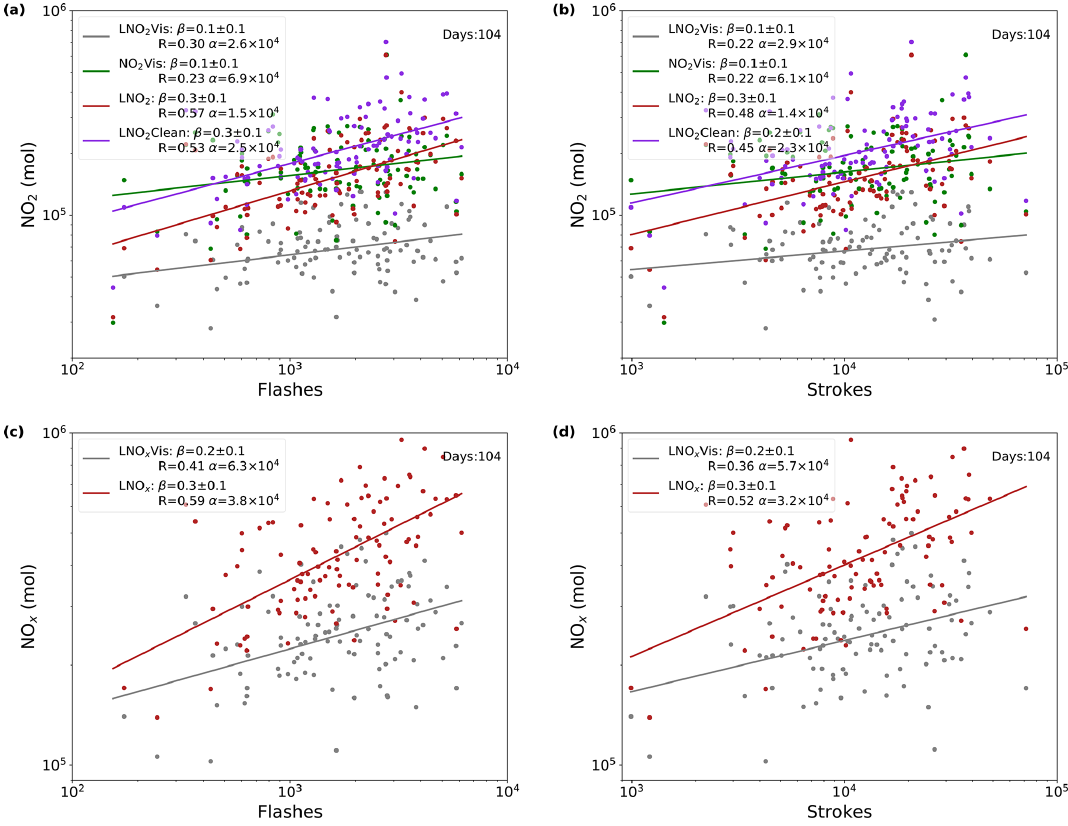
Figure B2. Same as Fig. B1 but using log-log axes.